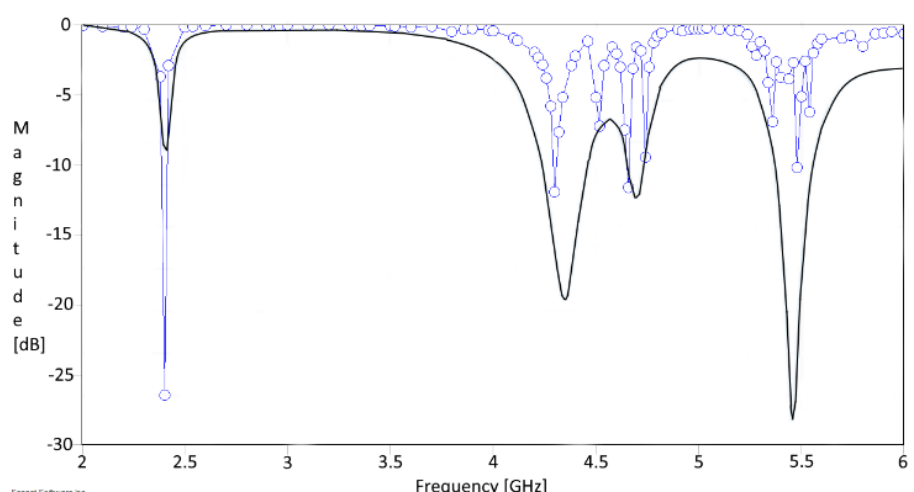
Figure 4. Simulated (bule) and measured (black) input match of proposed antenna from 2GHz to 6GHz